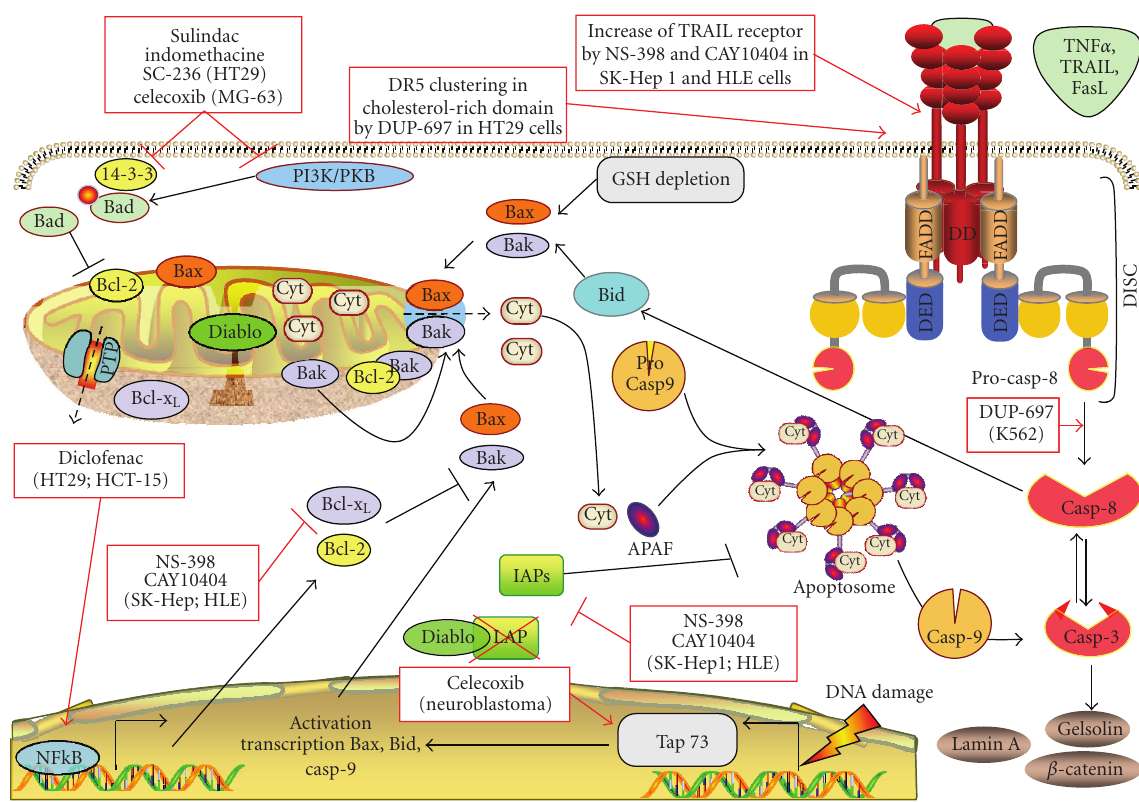
Figure 4: E ff ects of COX-2 inhibitors on apoptosis. Apoptosis can be mainly mediated by two pathways: the mitochondrial, intrinsic, or stress-induced apoptosis, which is activated in response to damaging stresses and the extrinsic pathway, triggered by the binding of ligands to specific death receptors [51]. COX-2 inhibitors are able to modulate stress-induced apoptosis as well as extrinsic apoptosis in several cell types. In this picture, some examples of these interaction discussed in the text are presented for di ff erent cell types: LNCaP, prostate cancer; K562, chronic myeloid leukemia; HT29, colorectal cancer; SK-Hep 1 and HLE, human hepatocarcinoma cells; HepG2, hepatocarcinoma; Be17402, hepatocarcinoma; SMMC-7402, hepatocarcinoma; MG-63, osteosarcoma. Abbreviation: AIF: apoptosis-inducing factor; Bcl-2, B cell lymphoma 2; Bid, Bcl-2 interacting domain; Casp, caspase; Cyt, cytochrome C; DD, death domain; DED, death e ff ector domain; DISC, death-inducing silencing complex; PI3K/PKB, phosphatidyl inositol-3 kinase/protein kinase B; FADD, Fas-associated death domain; GSH, glutathione; PTP, transition permeability pore; TNF, tumor necrosis factor; TRAIL,